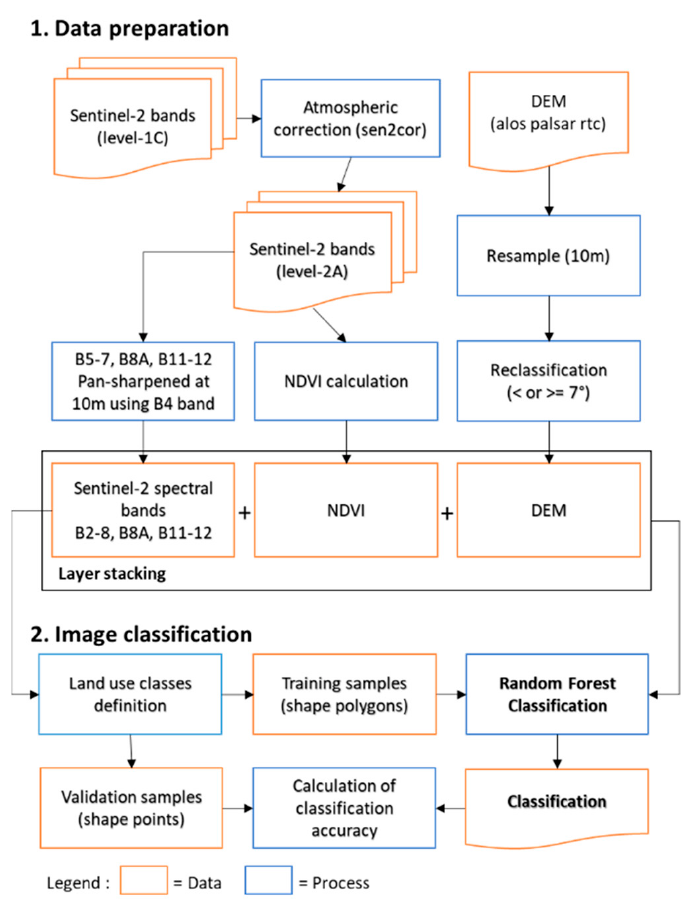
Figure 3. Image classi fi cation fl owchart.